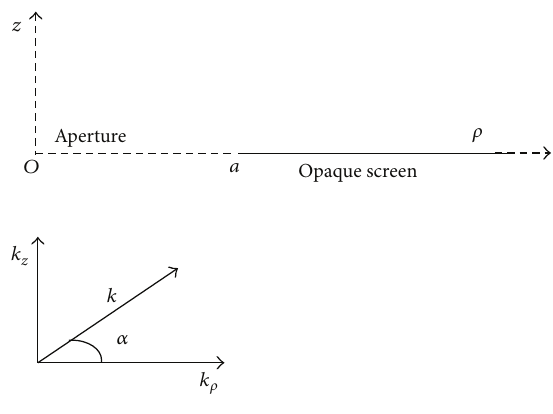
Figure 1: The geometry of the